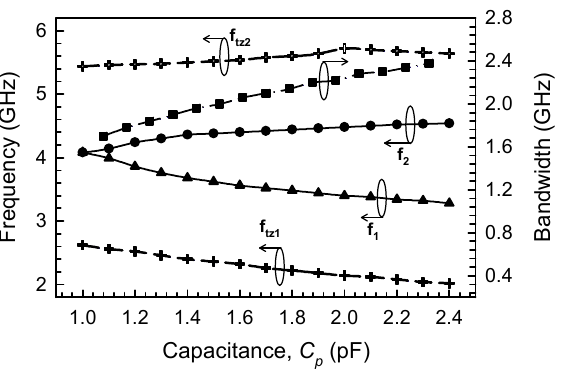
Figure 9. Mode (f 1 and f 2 ) and transmission zero (f tz1 and f tz2 ) frequencies and bandwidth variation depending on C p .